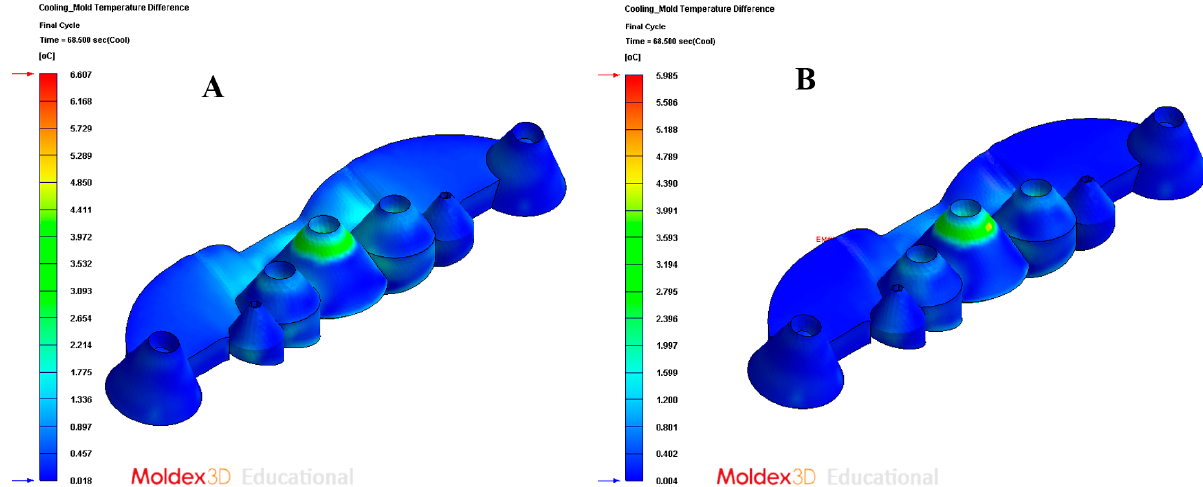
Figure 24. Mold temperature difference. ( A ) Traditional cooling; ( B ) conformal cooling.